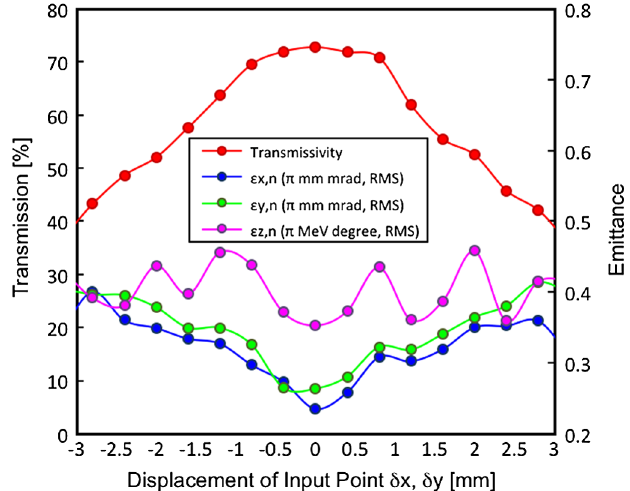
FIG. 13. Transmission and output emittance as a function of position error of input beam to the linac.